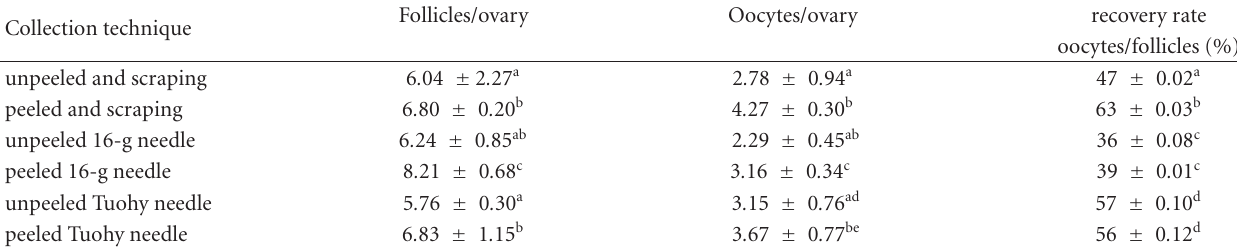
Figure 1: Tuohy needle showing its curved tip (a) and a representative image inside a sectioned 1cm mare follicle (b). Table 1: Mean number of follicles and oocytes per ovary and recovery